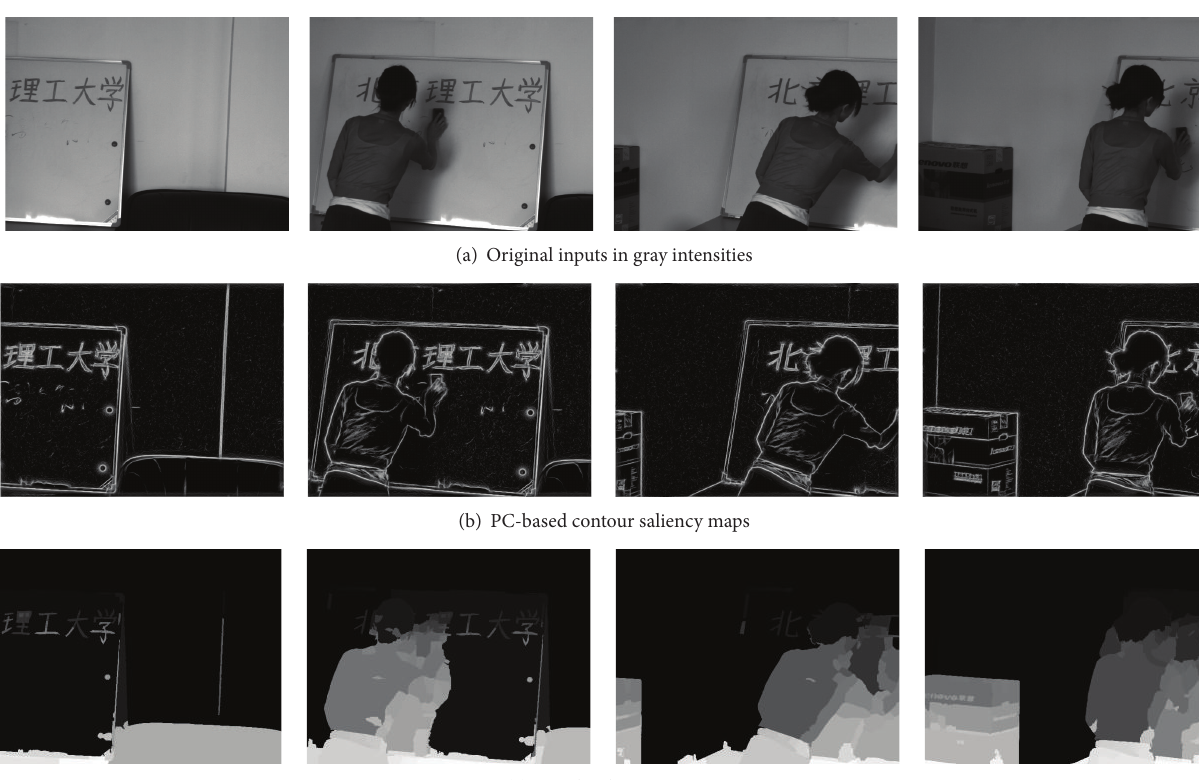
Figure 6: Multiple visual stimuli of dynamic scene